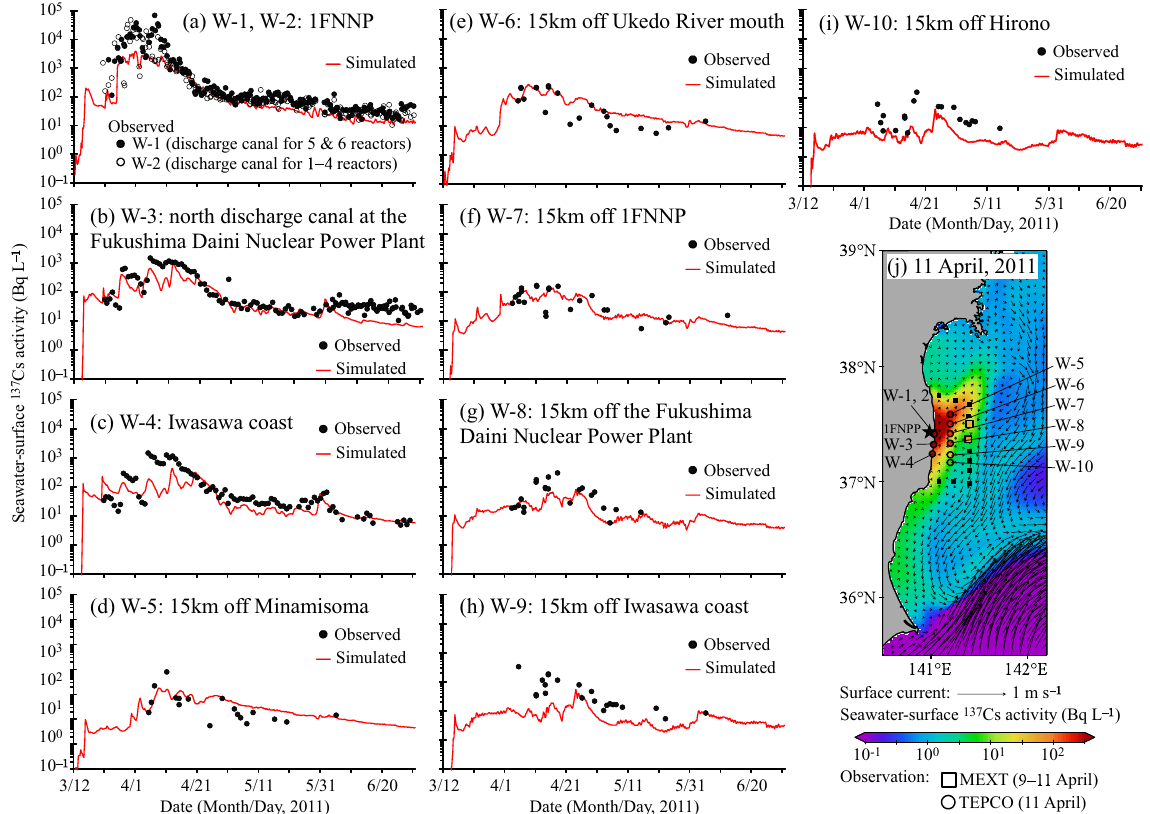
Figure 4. (a) – (i) Time series of observed and simulated seawater-surface 137 Cs at TEPCO (2011) stations W-1 through W-10. (j) Location of the stations and an example of spatial distributions in observed (colour square plot) and simulated 137 Cs (colour shading) on sea surface (11 April 2011). Arrows show daily-mean current on sea surface. Black star indicates location of 1FNPP. Black square plots indicate observations of non-detected seawater 137 Cs